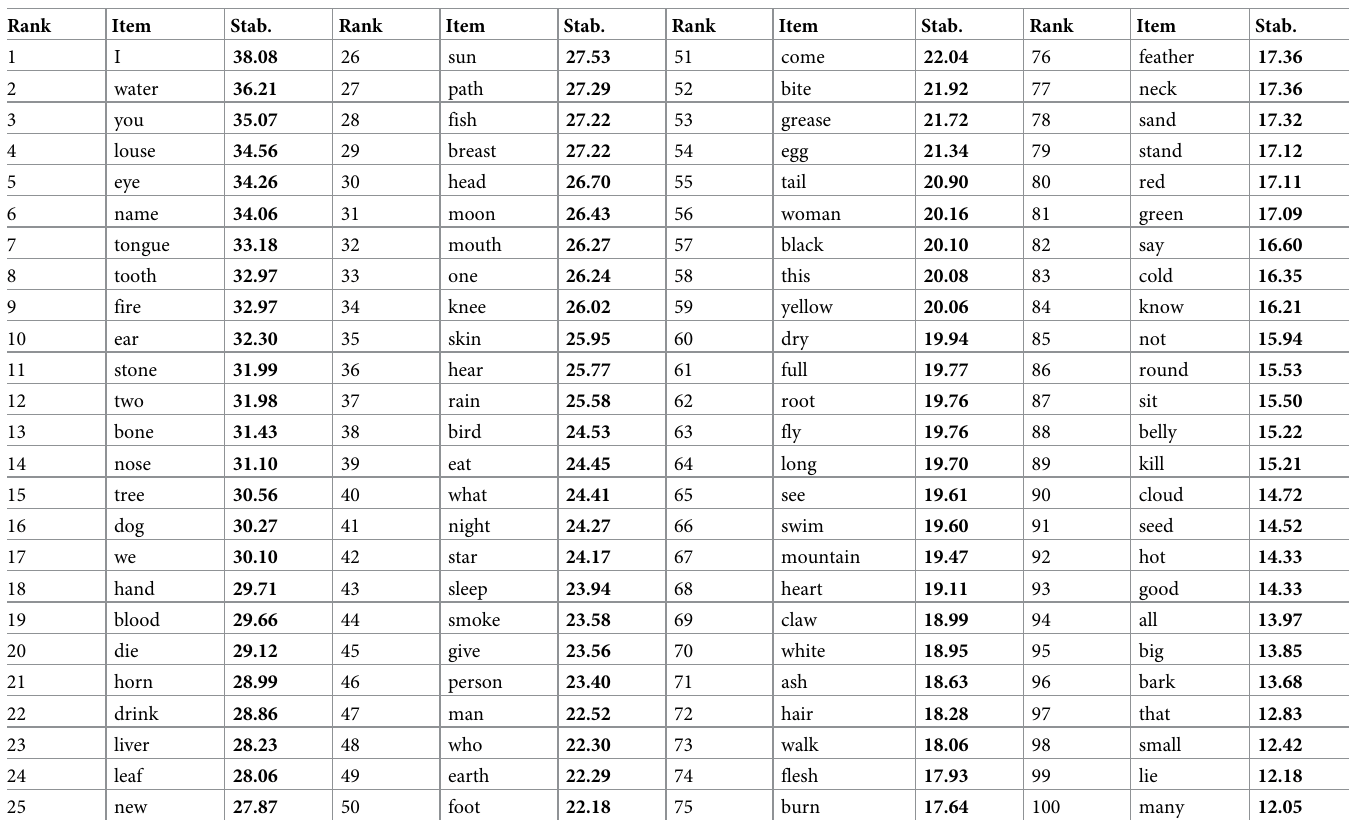
Table 3. Stability of items measured as ASJP similarity aggregated over WALS genera (apparent ties are ranked according to unrounded values). Rank Item